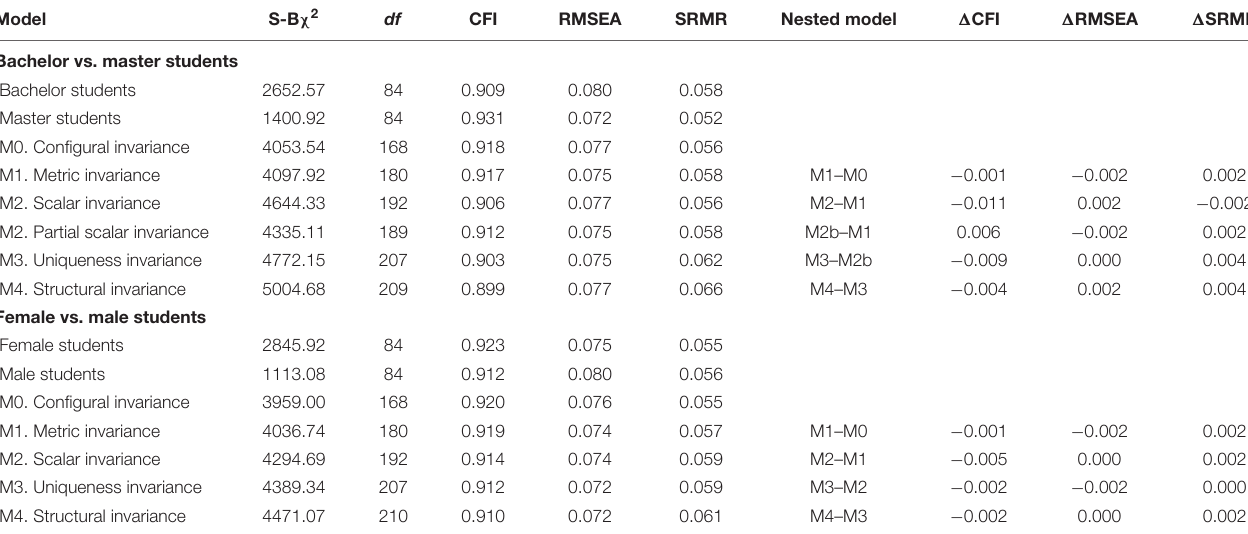
TABLE 3 | Test of invariance of the proposed three-factor structure of the MBI-SS between bachelor ( n = 4723) and master ( n = 3034) students, and female ( n = 5843) vs. male students ( n = 1914): results of multigroup CFAs.